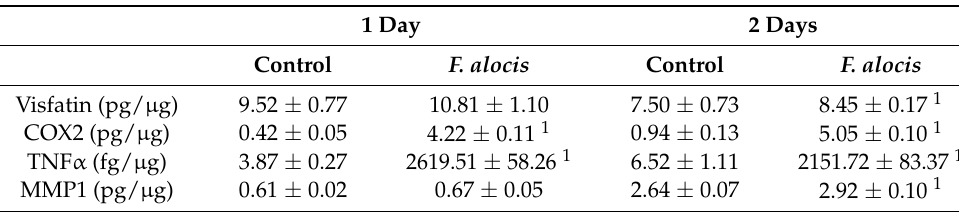
Table 1. Protein levels in supernatants (visfatin, TNF α , and MMP1) and cell lysates (COX2) of human macrophages treated with F. alocis . 1 Day 2 Days Control F. alocis Control F. alocis Visfatin (pg/ µ g) 9.52 ±